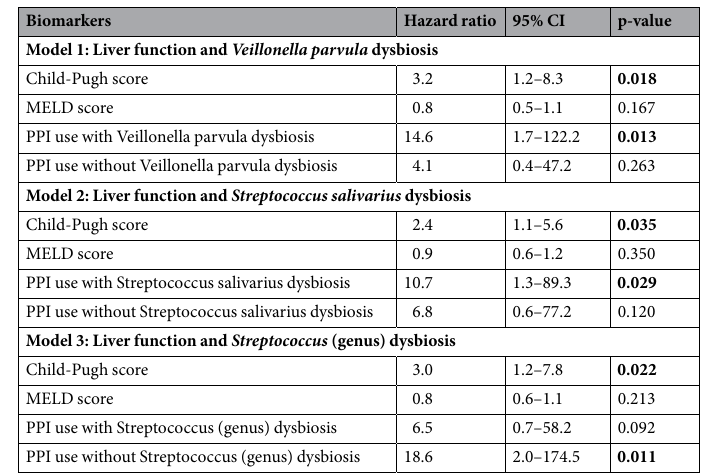
Table 2. Hazard ratios (liver-related three-year mortality) for PPI-associated dysbiosis adjusted for liver disease by multivariate Cox-Regression. CI: confidence interval; MELD: model of end stage liver disease; PPI: proton pump